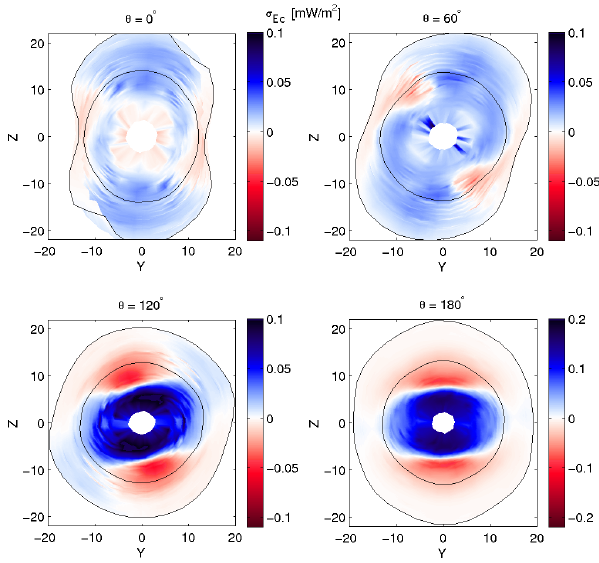
Fig. 6. Energy conversion surface density on the magnetopause un- der four different IMF orientations. The IMF direction is shown by an arrow and also given in degrees above each panel. The lines are intersections of the magnetopause with the planes X = 0 and X =− 30. The white hole at the subsolar point is a technical feature caused by the plotting procedure. Note the different colour scale in the lower-right